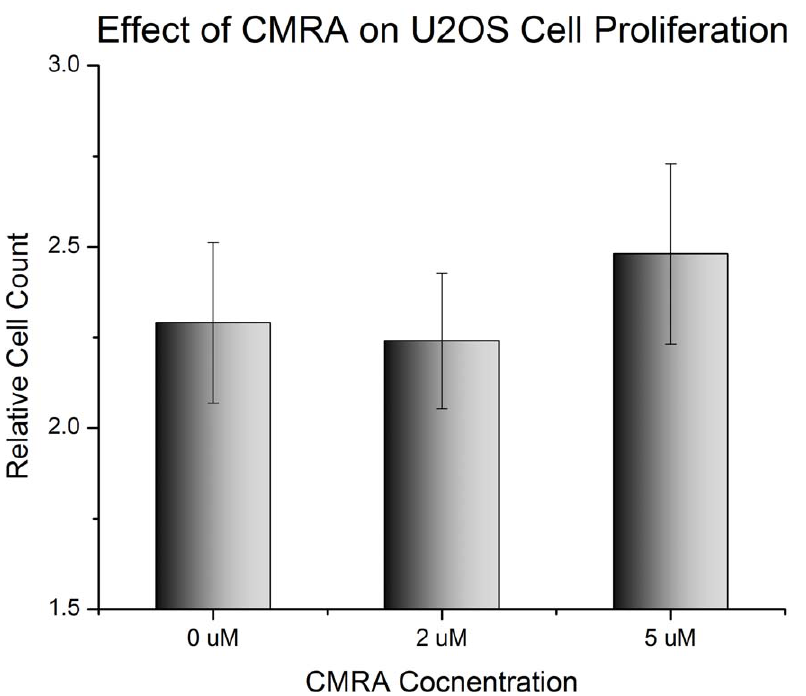
Figure 3. Proliferation of U2OS in 3D collagen gels with different concentration of live cell dye CMRA. Cells were grown in 3 mg/ml collagen gels. Cells were counted immediately after seeding and 96 h post-seeding. Data is presented as a ratio of 96 h data to 0 h data. No significant difference in cell proliferation was observed.